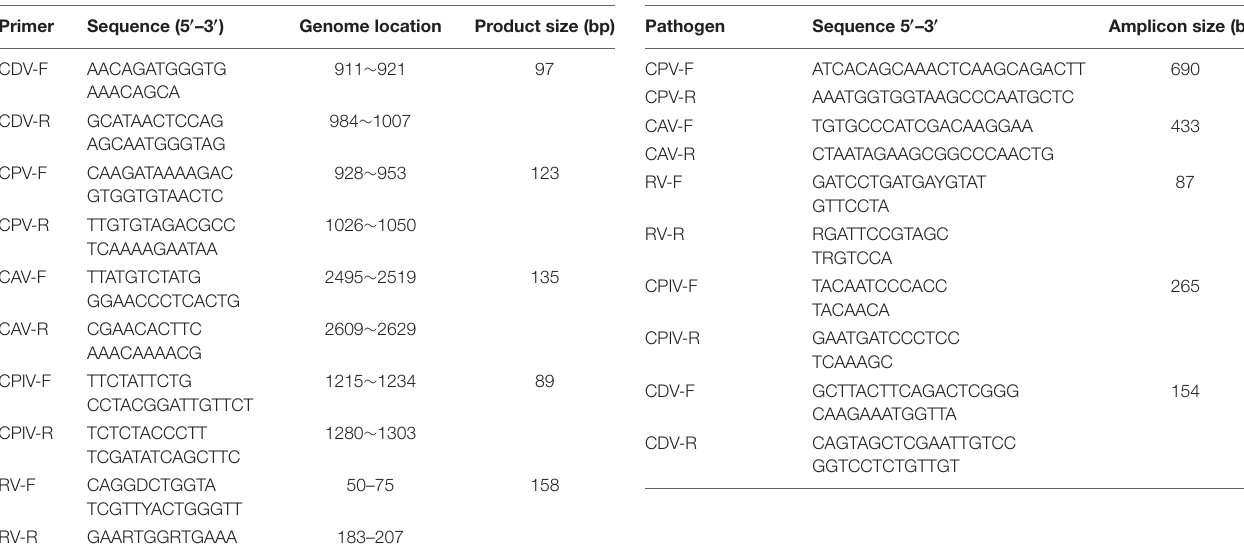
TABLE 1 | Primers used in the multiplex xTAG assay. TABLE 2 | Primers used for the conventional PCR method.